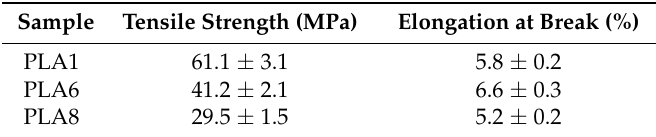
Table 6. Mechanical properties of PLA and PLA/IFR